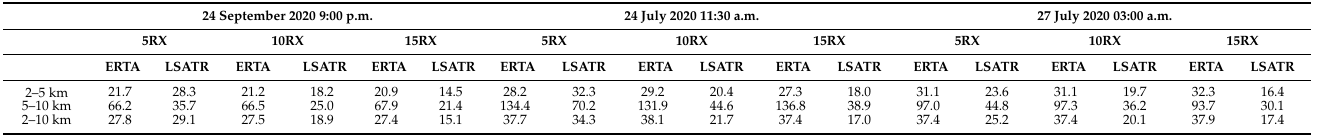
Table 1. Percent NRMSE obtained from the reconstructions of the WV fields for the considered three scenarios, by using ERTA and LSATR. The values refer to the whole field (2–10 km), to a low (2–5 km) and high (5–10 km) tropospheric altitude